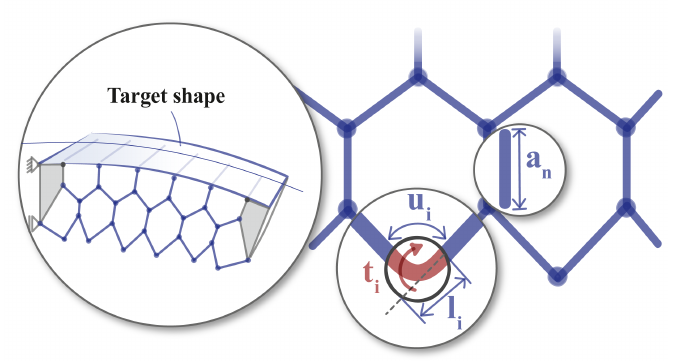
Figure 5. Geometric design parameters used by the form-finding algorithm. Reprinted/adapted by permission from Springer Nature